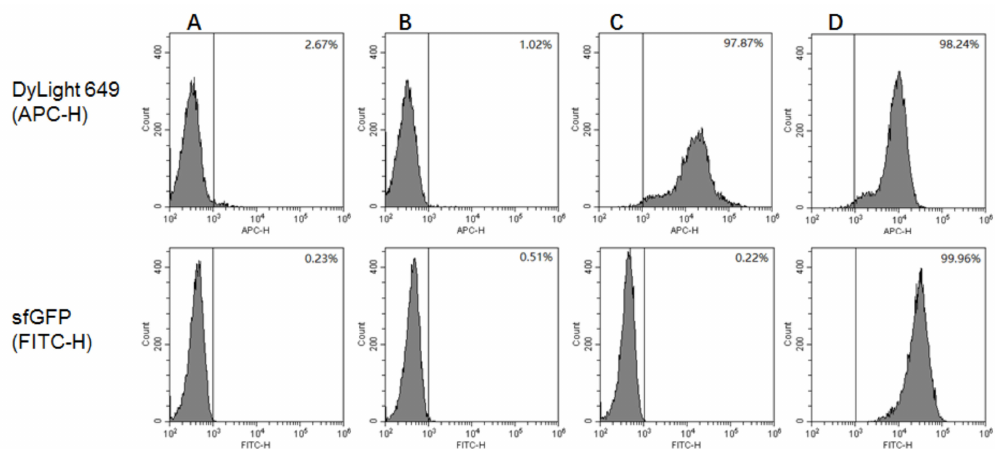
Figure 4. Flow cytometry analysis of P. pastoris cells including ( A ) unlabeled GS115/pPICZ α A, ( B ) GS115/pPICZ α A, ( C ) GS115/pPICZ α A HA ‐ SED1 and ( D ) GS115/pPICZ α A HA ‐ Im7 ‐ SED1. All the cells except ( A ) were treated with DyLight 649 ‐ conjugated goat anti ‐ mouse IgG(H+L) antibodies (top line) and with CL7 ‐ sfGFP and mouse anti ‐ HA tag monoclonal antibodies (bottom line).